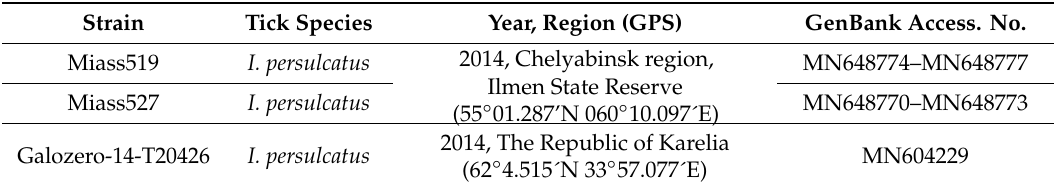
Table 1. Alongshan virus strains isolated in unfed adult Ixodes persulcatus ticks from two geographically separate regions of Russia.